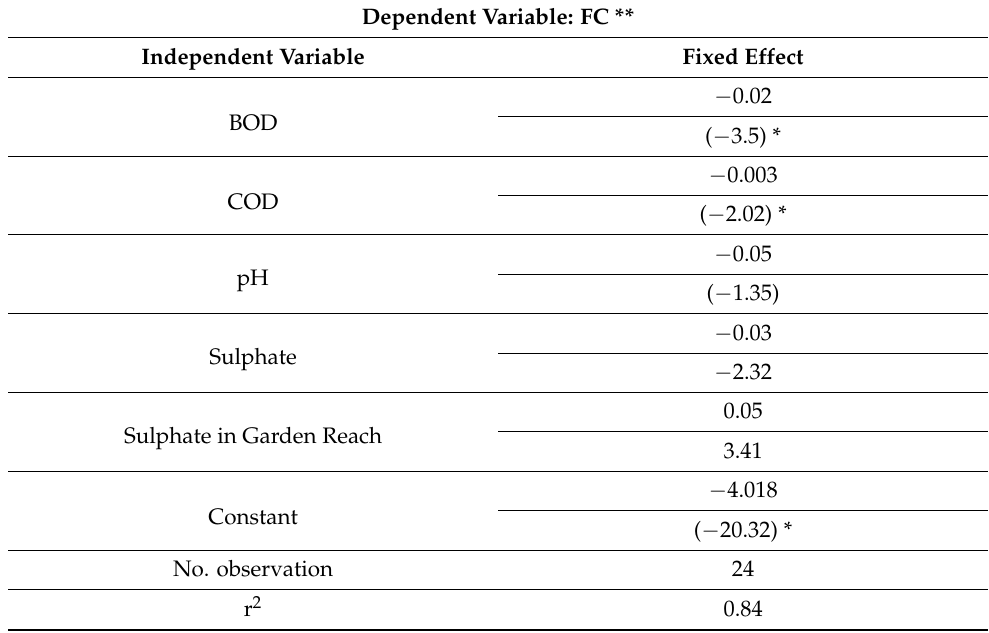
Table 3. Panel data analysis showing fixed effect of BOD, COD, pH and sulphate on FC during lockdown period (Apr–May